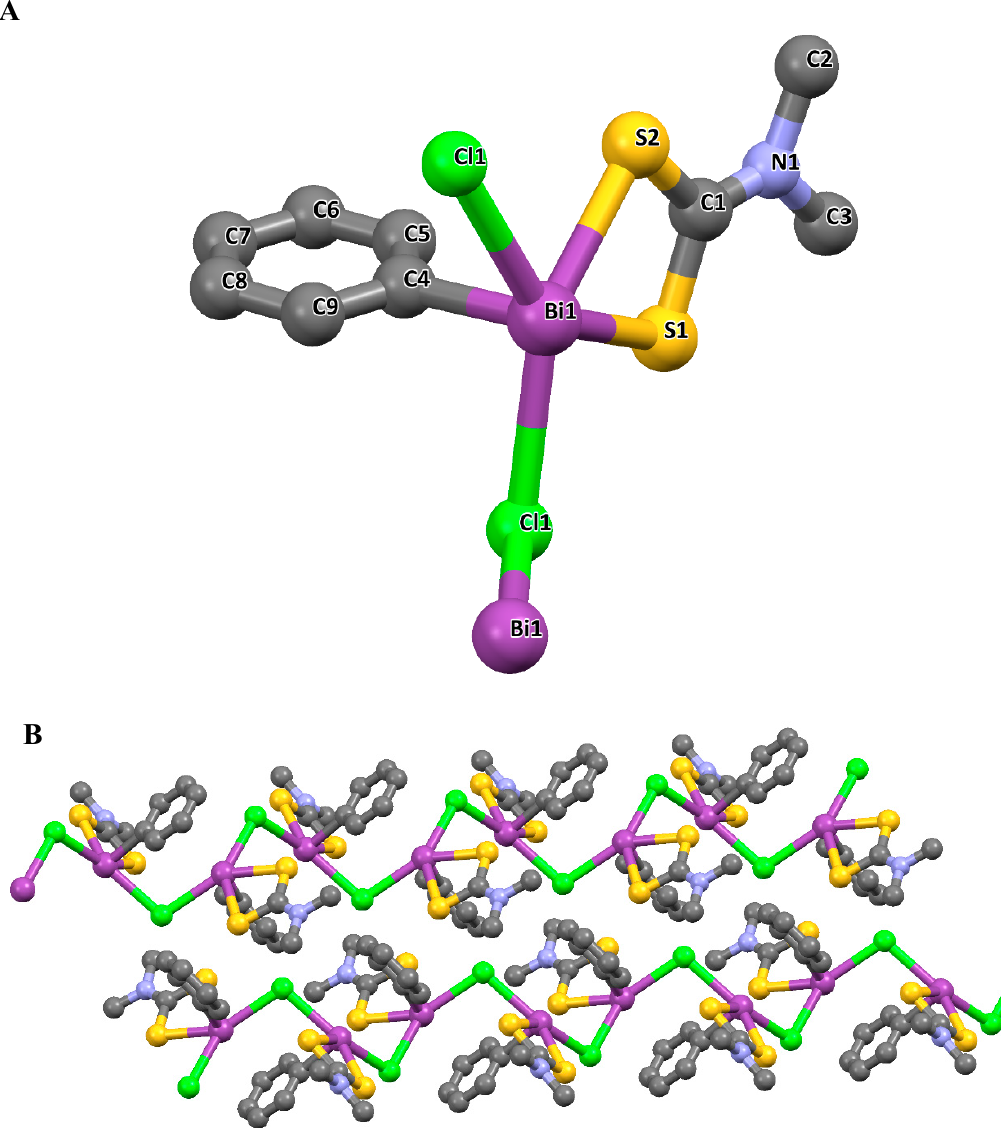
Figure 7. ( A ) Crystal structure of the complex and the labelling scheme [PhBiS 2 CN(CH 3 ) 2 Cl]n. All hydrogen atoms are omitted for clarity. ( B ) 2D structure of the complex [PhBiS 2 CN(CH 3 ) 2 Cl]n. All hydrogen atoms are omitted for clarity. Redrawn from [62], with permission from Taylor and Francis (copyright 2019).